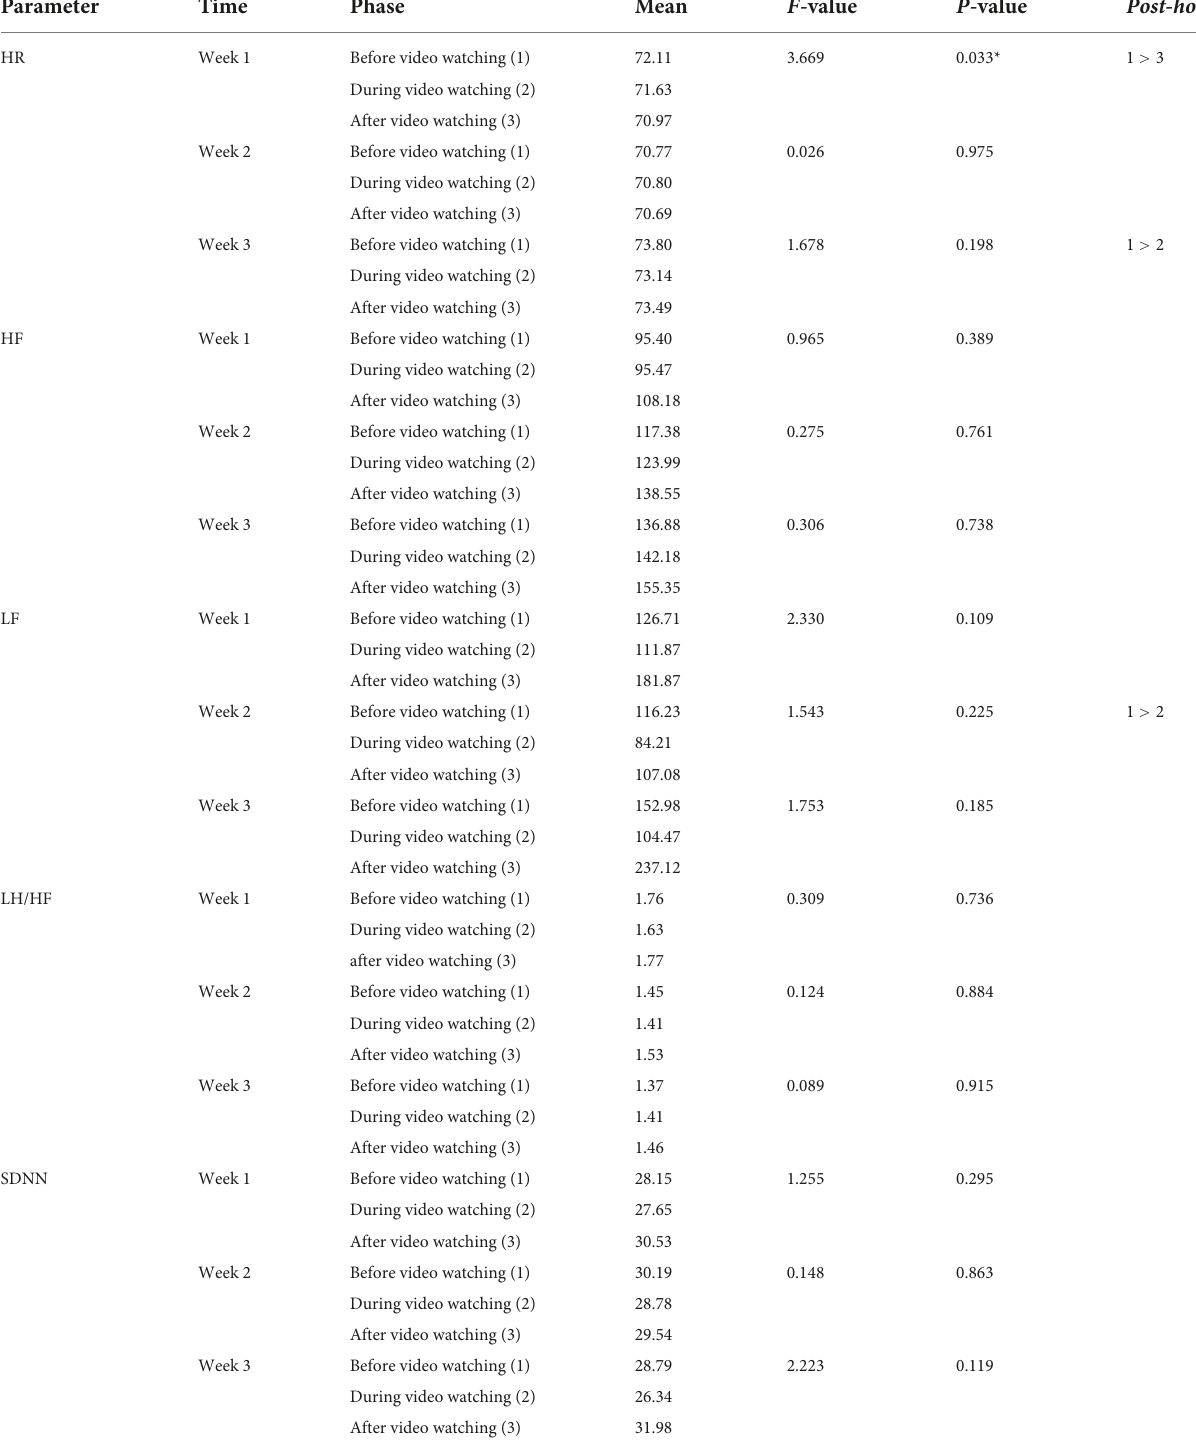
TABLE 2 The repeated measure ANOVA of HR and HRV parameters among three phases in 3 weeks.